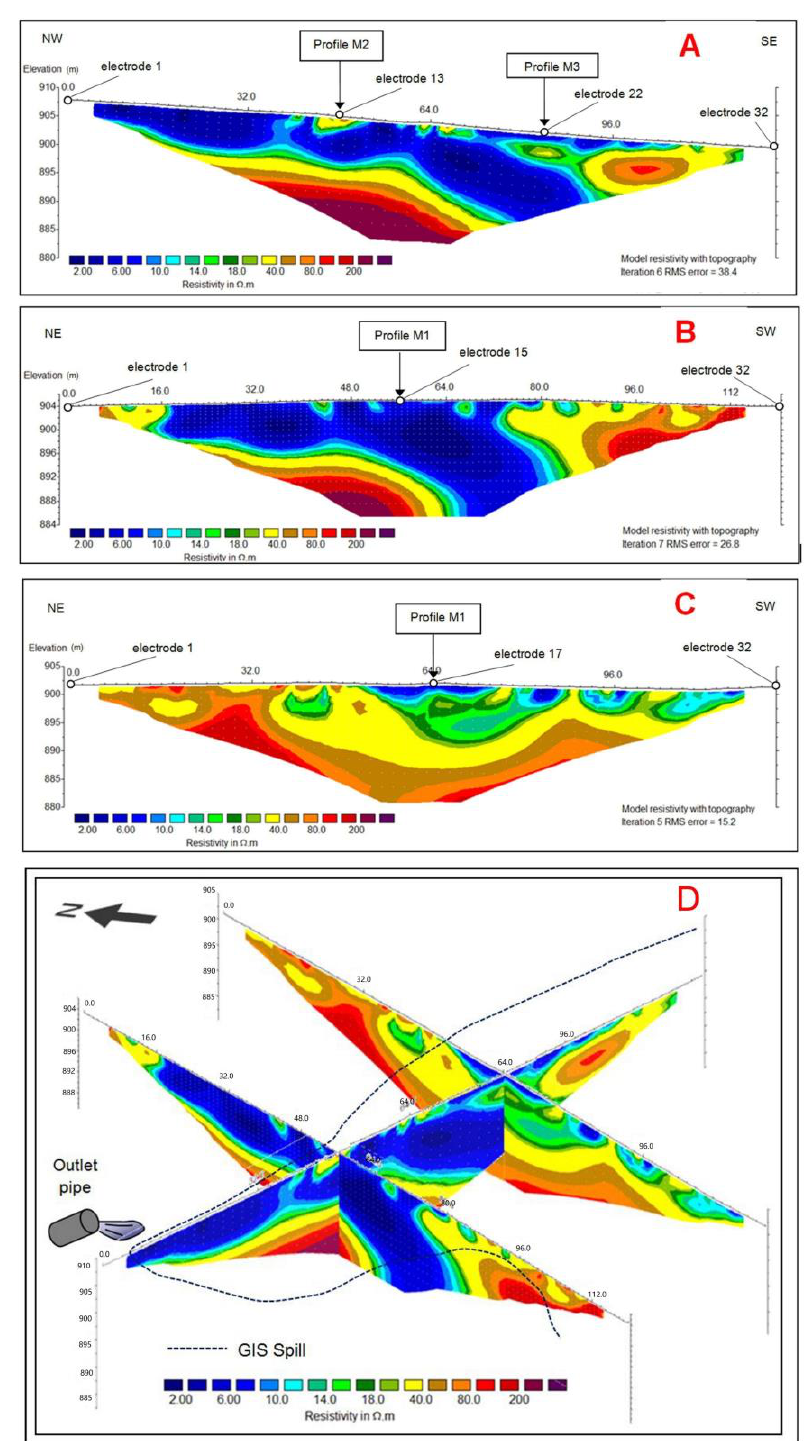
Figure 7. ERT (Electrical Resistivity Tomography) profiles M1 ( A ), M2 ( B ) and M3 ( C ), and 3D layout ( D ). The surface limit of the spill as deduced from GIS methodology is included (dashed line). The whole RMS (Root Mean Square) error (in %) is shown at the lower right corner of each profile. Figure 8 depicts a bar chart of RMS error statistics for the three profiles. It shows the percentage of difference between the measured and calculated apparent resistivity for the corresponding